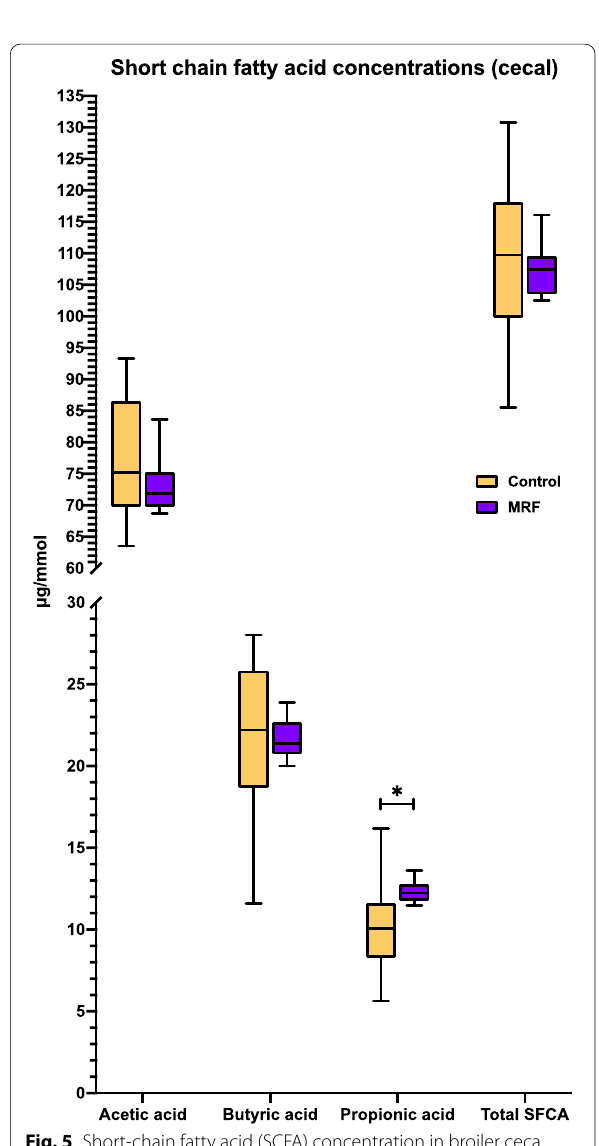
Fig. 5 Short-chain fatty acid (SCFA) concentration in broiler ceca. Statistical significance is denoted using an